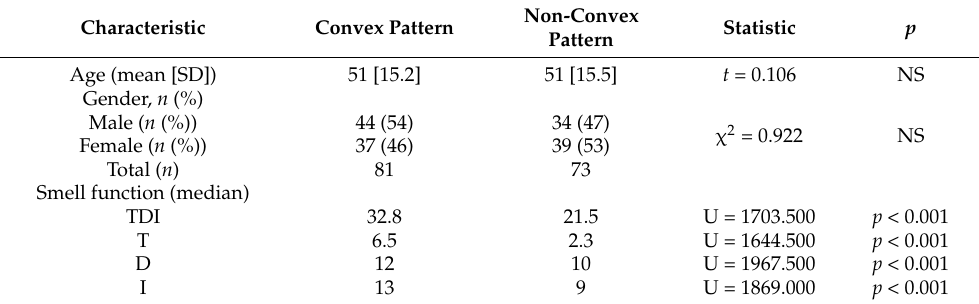
Table 2. Comparison between convex pattern and non-convex pattern across matched